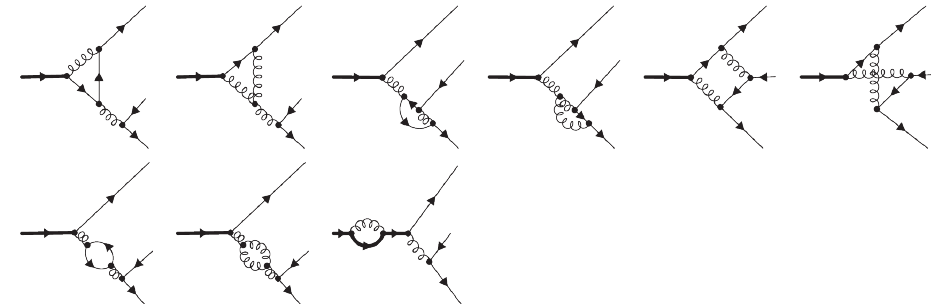
Figure 1 . 9 diagrams contributing to the splitting operator q → qq 0 ¯ q 0 . The thick incoming lines on the left side of each diagram correspond to the off-shell splitting parton. The outgoing lines on the right side of each diagram are on shell. The anti-quark line carries an arrow of direction opposite to that of the energy